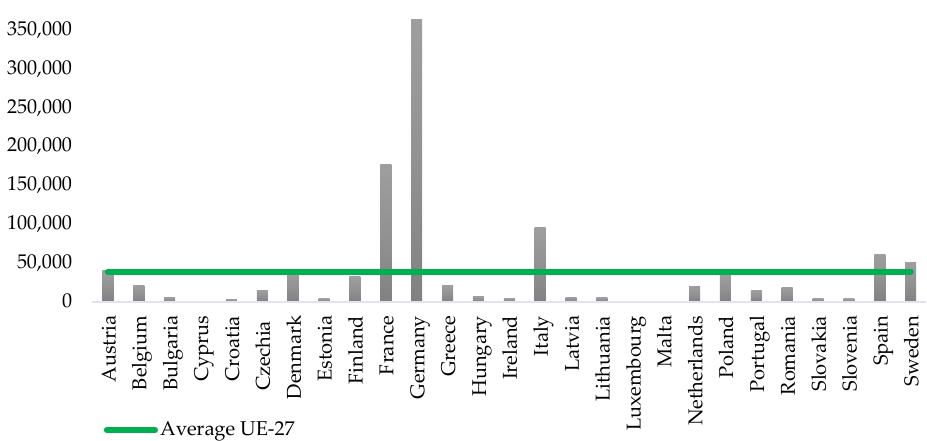
Figure 1. GJ in the RES sector (number of people employed) in EU countries in 2013. Source: Authors’ elaboration based on EurObserv’ER data.